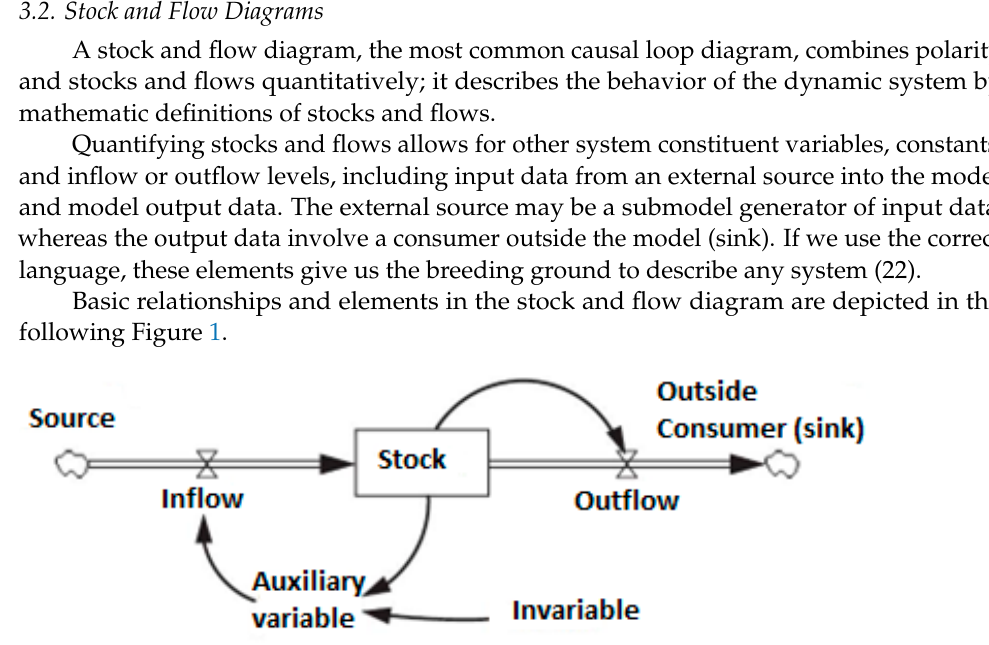
Figure 1. Depiction of basic relationships and elements in the stock and flow diagram [27]. Stocks represent a variable at a point in time. An increase or decrease in the stock reflects flow levels in the stock. Based on specific variables, the flow levels comprise func- tions of other interdependent model elements [27]. Constants are numerical values that remain invariant unless disturbed by a particular model